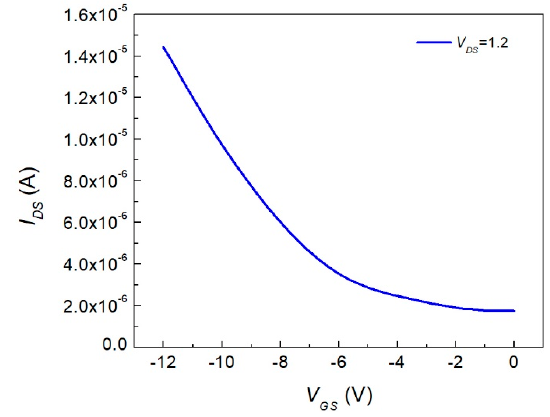
Figure 11. Square root current–voltage characteristics and slopes for the OFET.